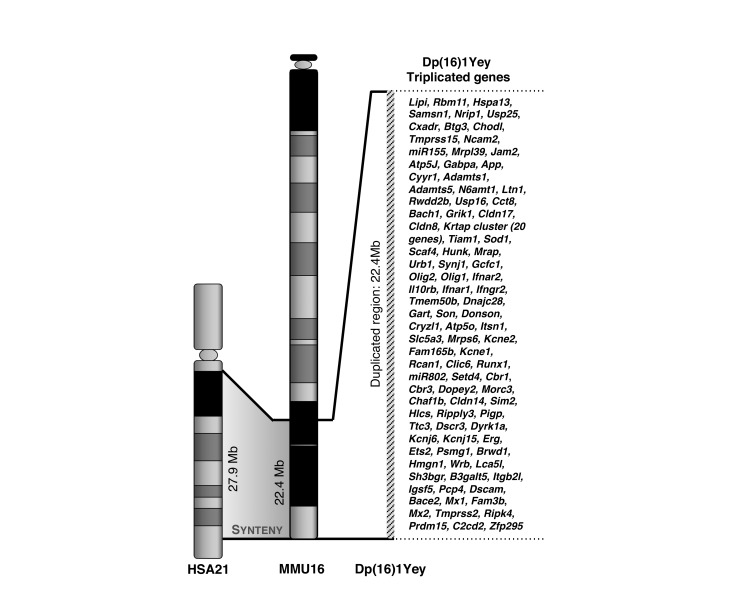
Human – mouse synteny allows modeling Down syndrome in mice.Human chromosome 21 (HSA21) possesses a large region of synteny to the distal part of mouse chromosome 16 (MMU16), conserving gene content, order and relative orientation. The Dp(16)1Yey carries a tandem duplication for the entire region of synteny on MMU16 spanning from Lipi to Zfp295 (~98 known protein coding genes). This 22.4 Mb duplication was obtained by Cre-loxP mediated chromosomal engineering.